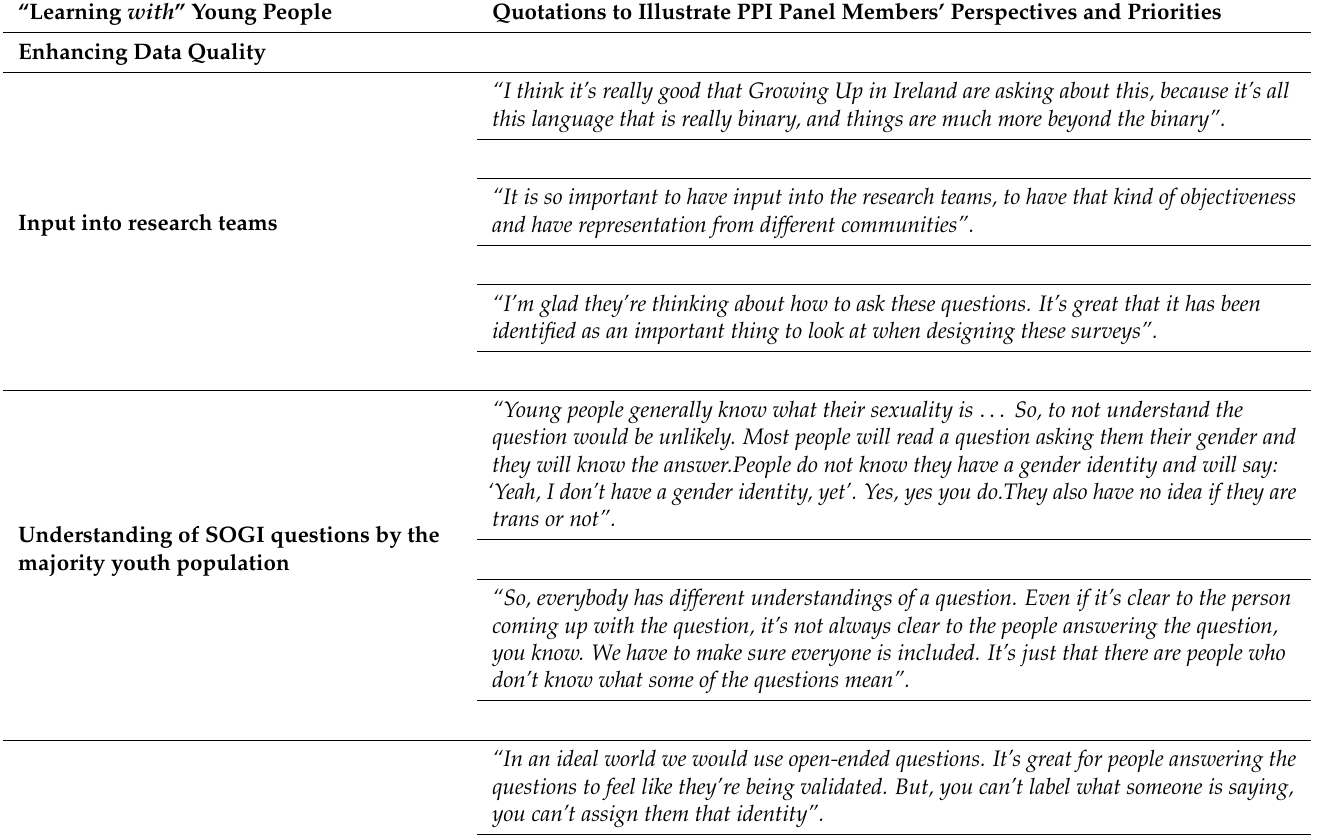
Table 5. PPI Panel members’ reflections on “learning with ” young people regarding SOGI question placement and